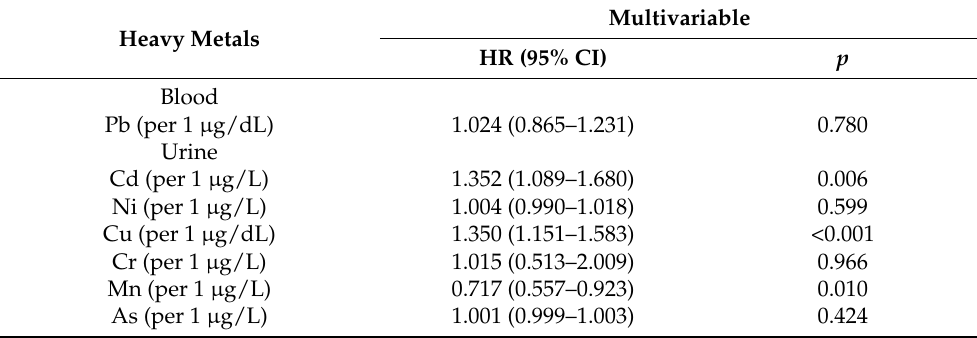
Table 3. Association of heavy metals with overall mortality using multivariate Cox proportional hazards